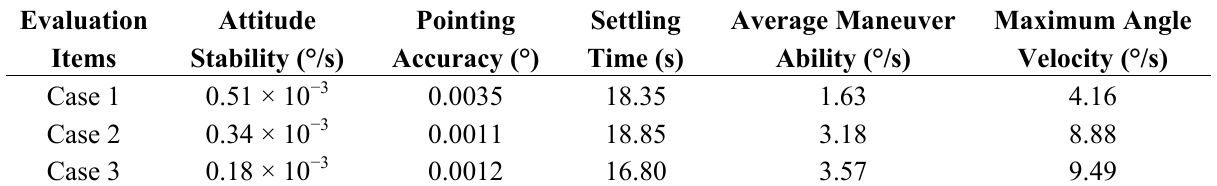
Table 3. Experimental Results of Three